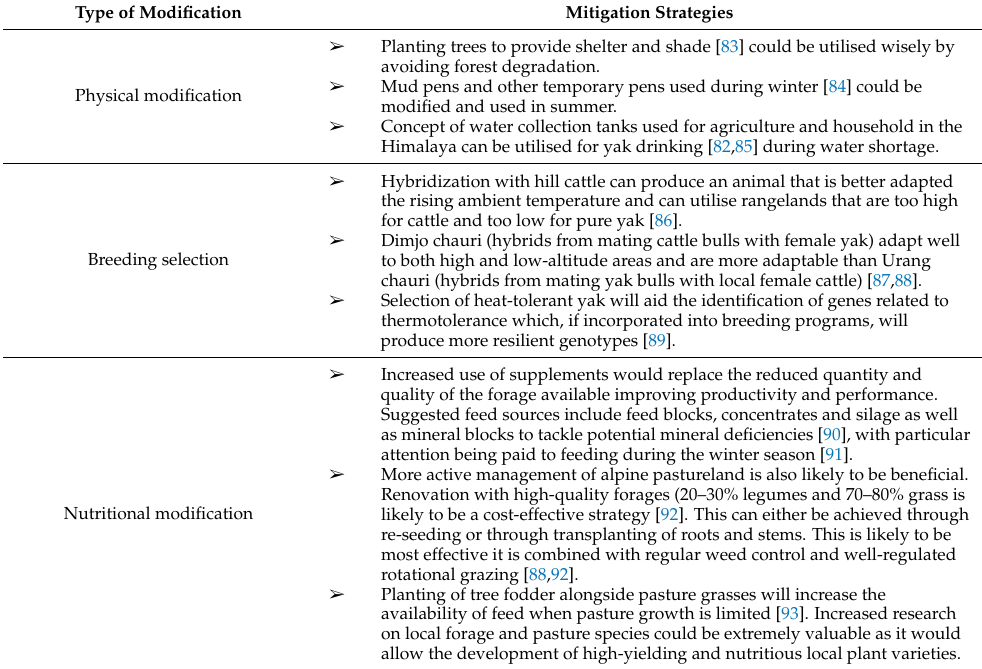
Table 3. Summary of some potential strategies to mitigate the effect of climate change on Himalayan